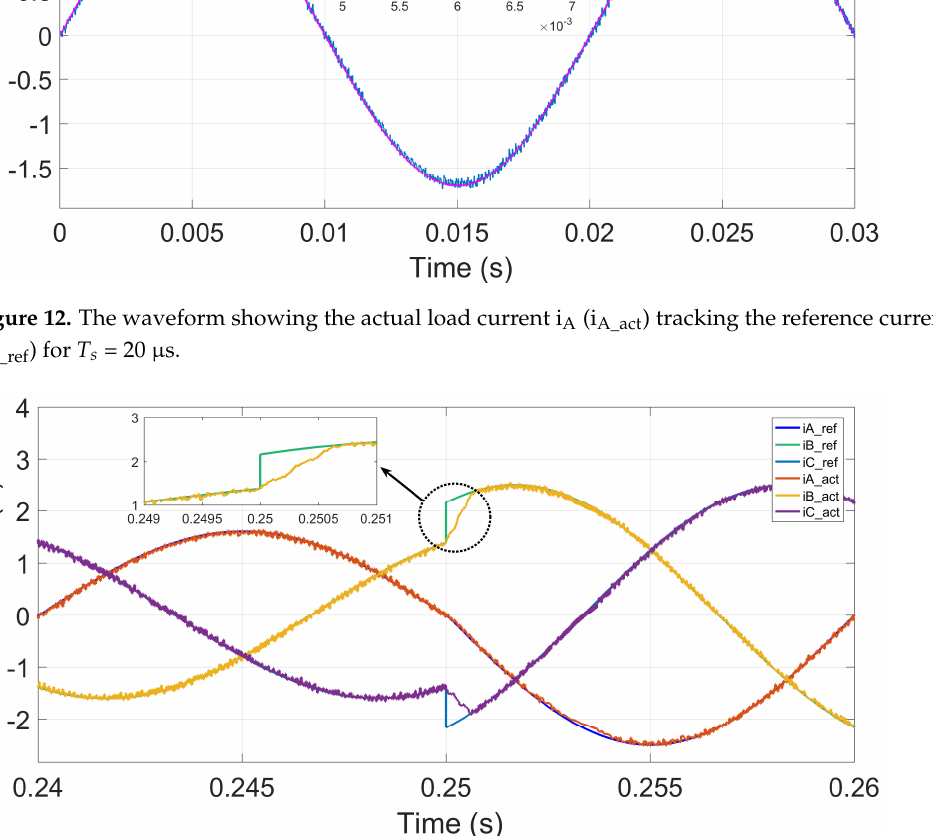
Figure 13. The waveform representing the dynamic response of the load current for a step-change in the reference current for T s = 20 μs.